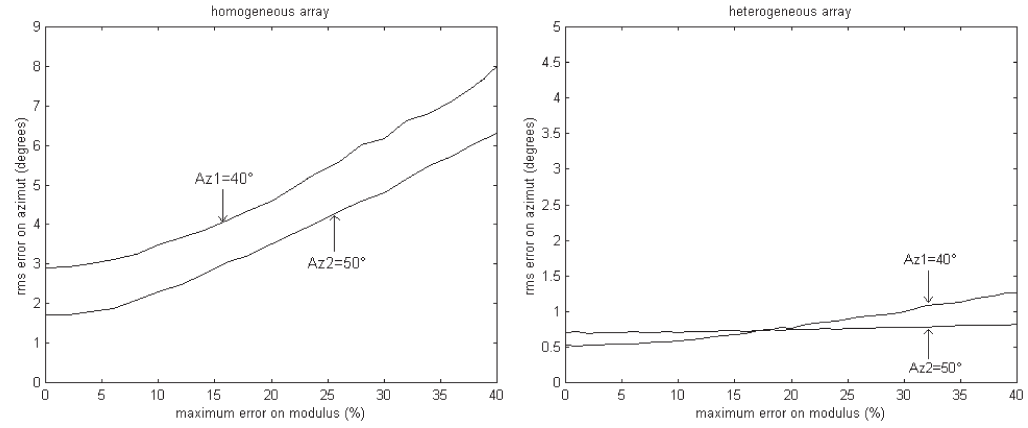
Fig. 7.a,b. RMS error, homogeneous array (left frame) and heterogeneous array (right